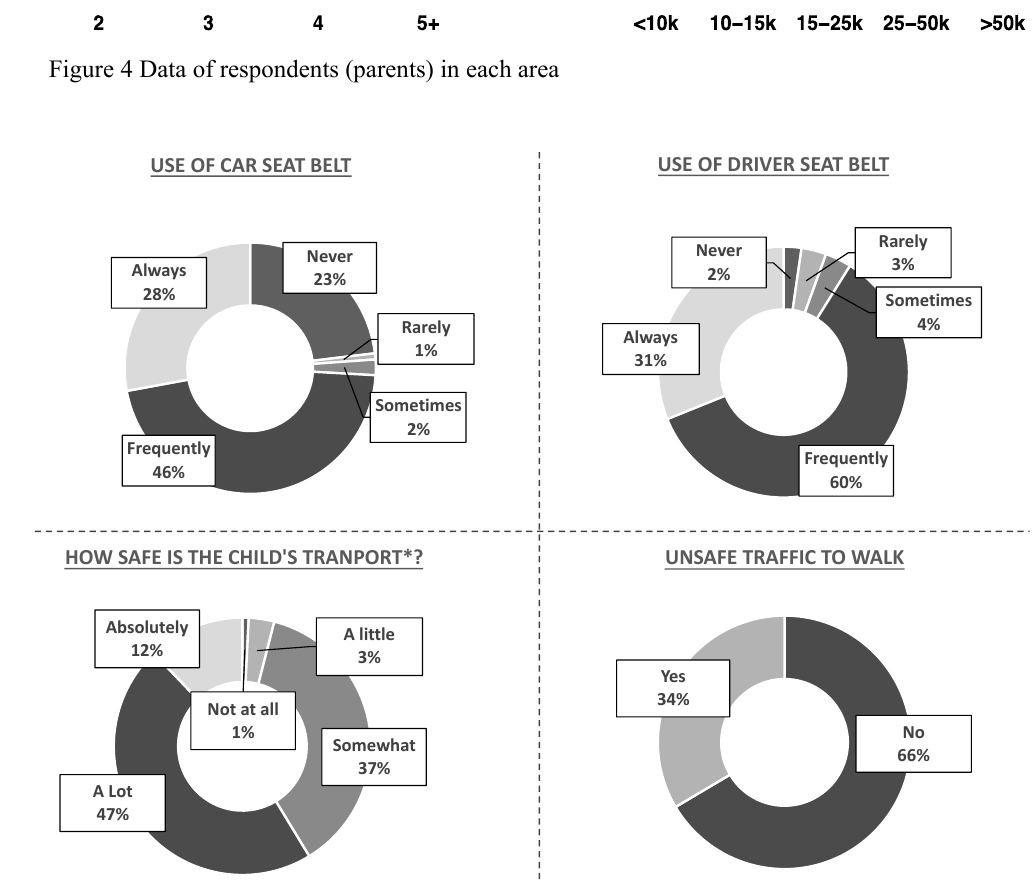
Figure 5 Statistics of key variables extracted from the collected